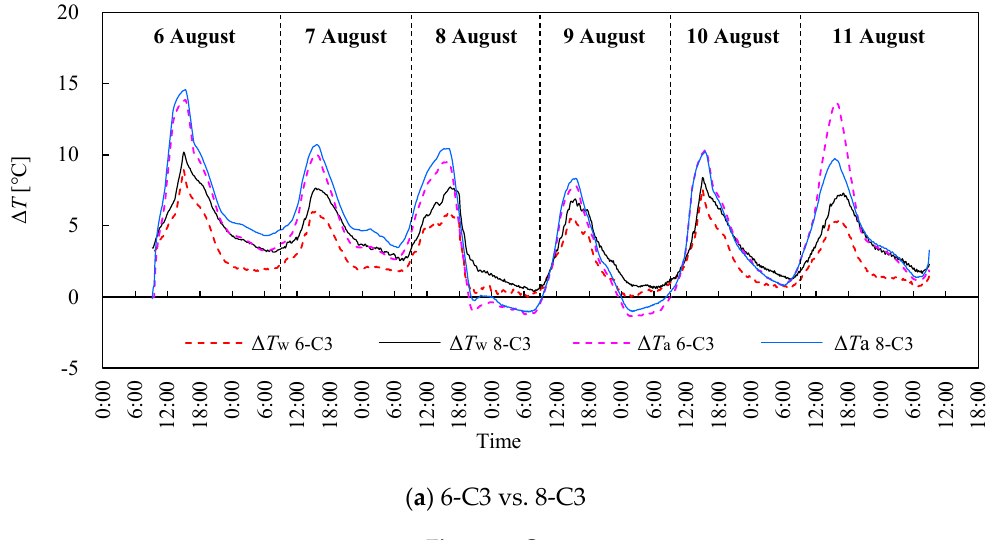
( a ) 6-C3 vs. 8-C3 Figure 8. Cont